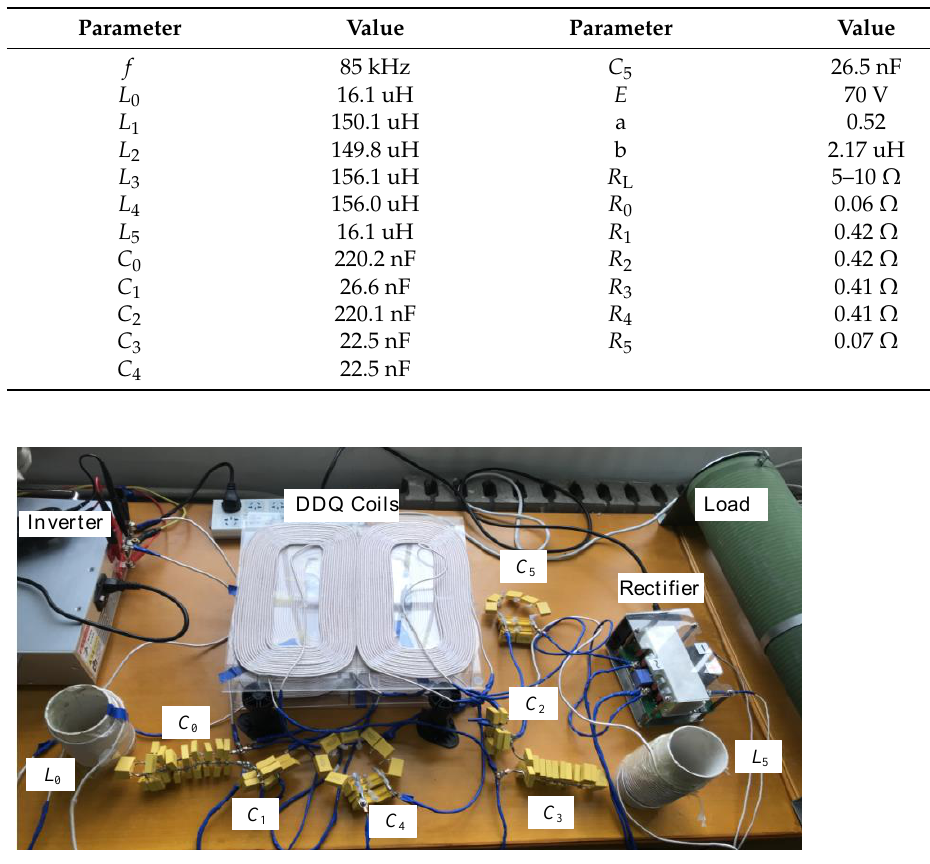
Figure 9. Experimental platform. Table 1. Experimental parameters of the system.